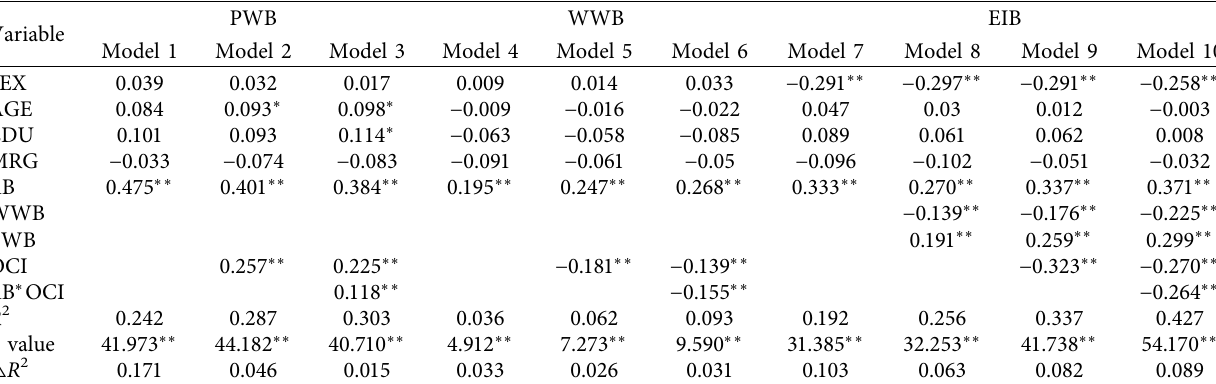
Table 4: Hierarchical regression modeling ( N �